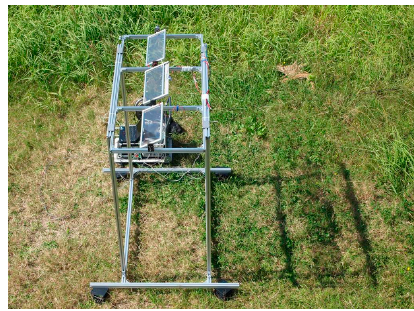
Figure 2. Electrical characteristics of the PV blind system consisting of the three PV modules were measured at a field plot on the Shimane University campus (35°29 ′ N, 133°04 ′ E) on 10 October 2017. measured at a field plot on the Shimane University campus (35 ◦ 29 (cid:48) N, 133 ◦ 04 (cid:48) E) on 10 October